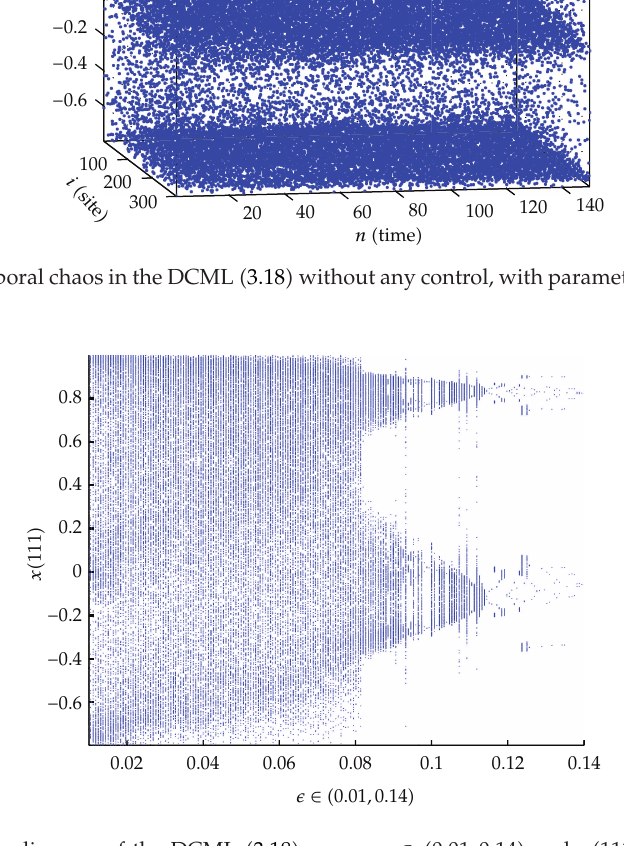
Figure 2: Bifurcation diagram of the DCML (cid:3) 3.18 (cid:4) versus (cid:2) ∈ (cid:3) 0 . 01 , 0 . 14 (cid:4) and x (cid:3) 111 (cid:4) , with initial point (cid:3) 0 . 6 ,..., 0 . 6 (cid:4)